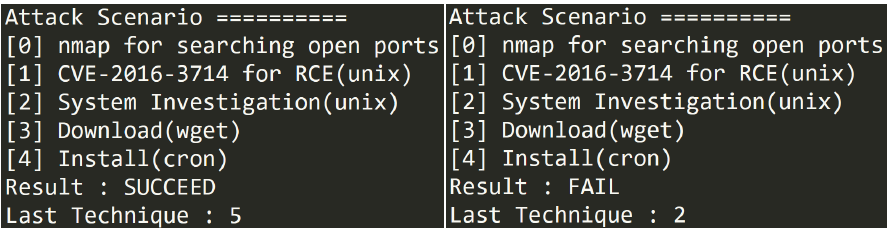
Figure 18. The success (left) and the failure (right) of the red team agent’s attacks exploiting CVE-2016-3714 on the system.